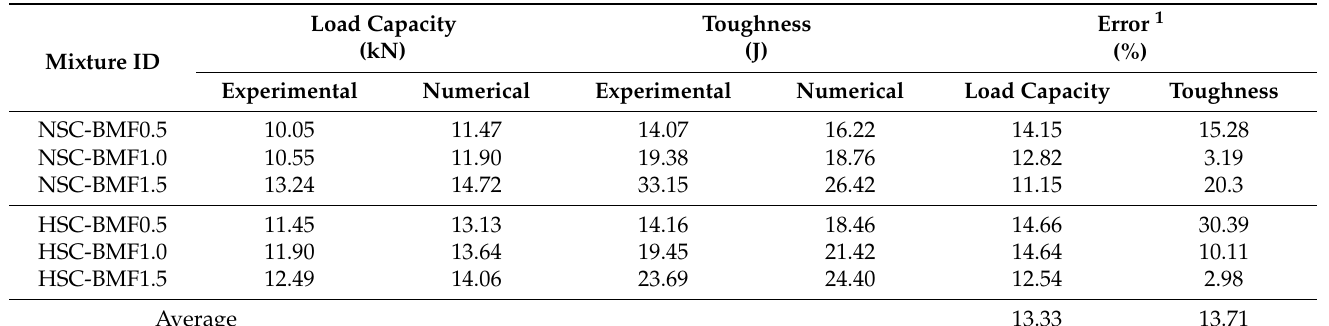
Figure 25. Numerical versus experimental flexural response of HSC: ( a ) ν f = 0.5%; ( b ) ν f = 1.0%; ( c ) ν f = 1.5%. Table 11. Comparison between experimental and numerical